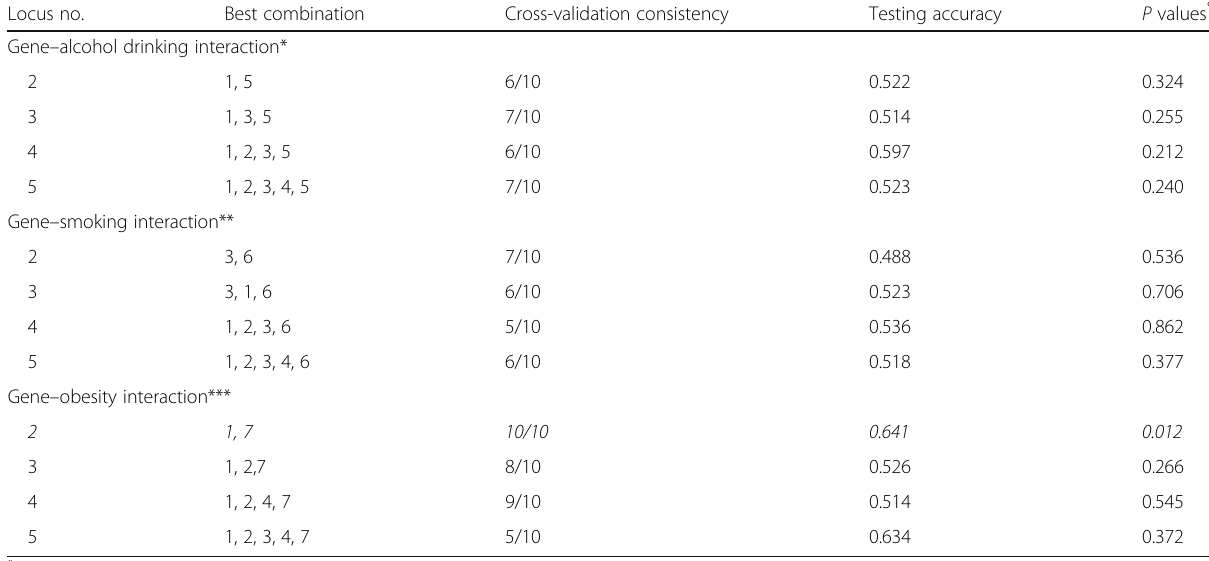
Table 4 Best gene – environment interaction models as identified by GMDR Locus